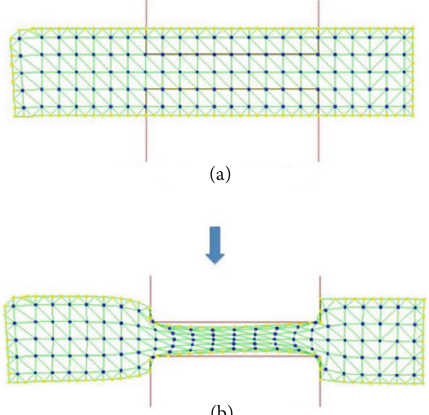
Figure 15: Collision avoidance between the crowd and obstacles: (a) the mesh generated from crowd getting through the obstacles; (b) mesh deformation application to avoid